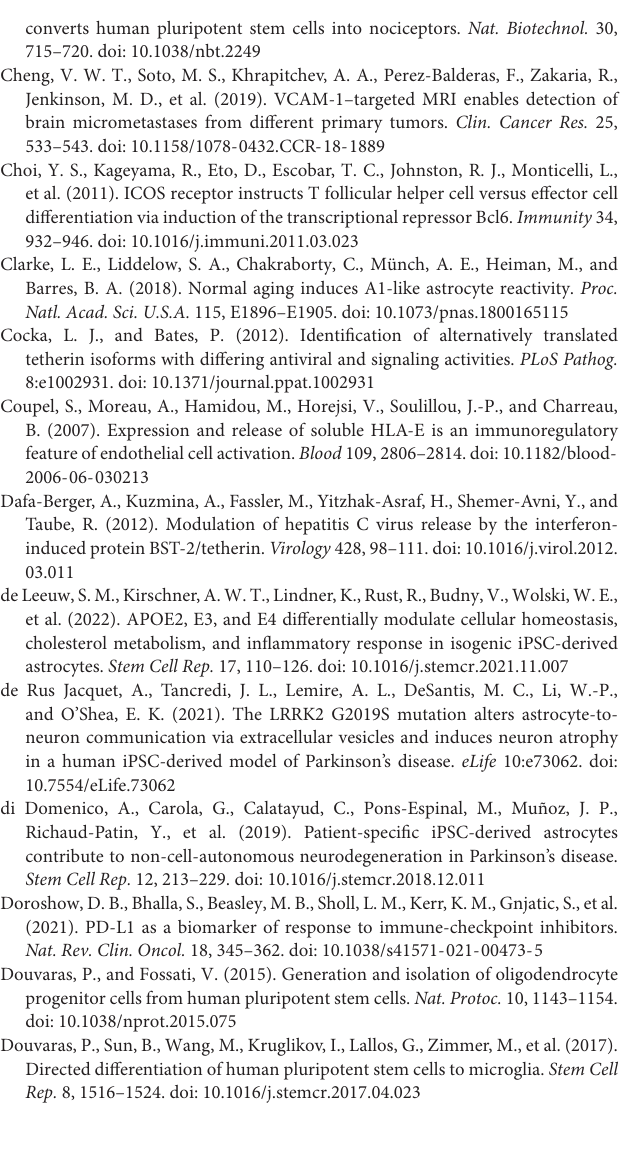
Supplementary Table 1 | List of DE proteins from whole proteome analysis. Supplementary Table 2 | List of biological processes identified through pathway enrichment